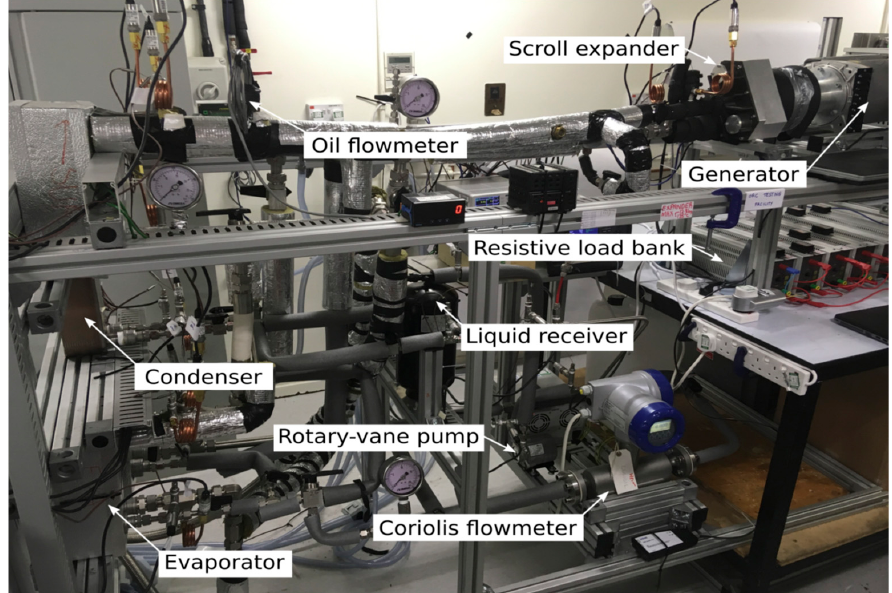
Figure 3. Experimental test facility and ORC prototype (taken from [19]). Table 1. Components specification of the ORC test prototype [32].